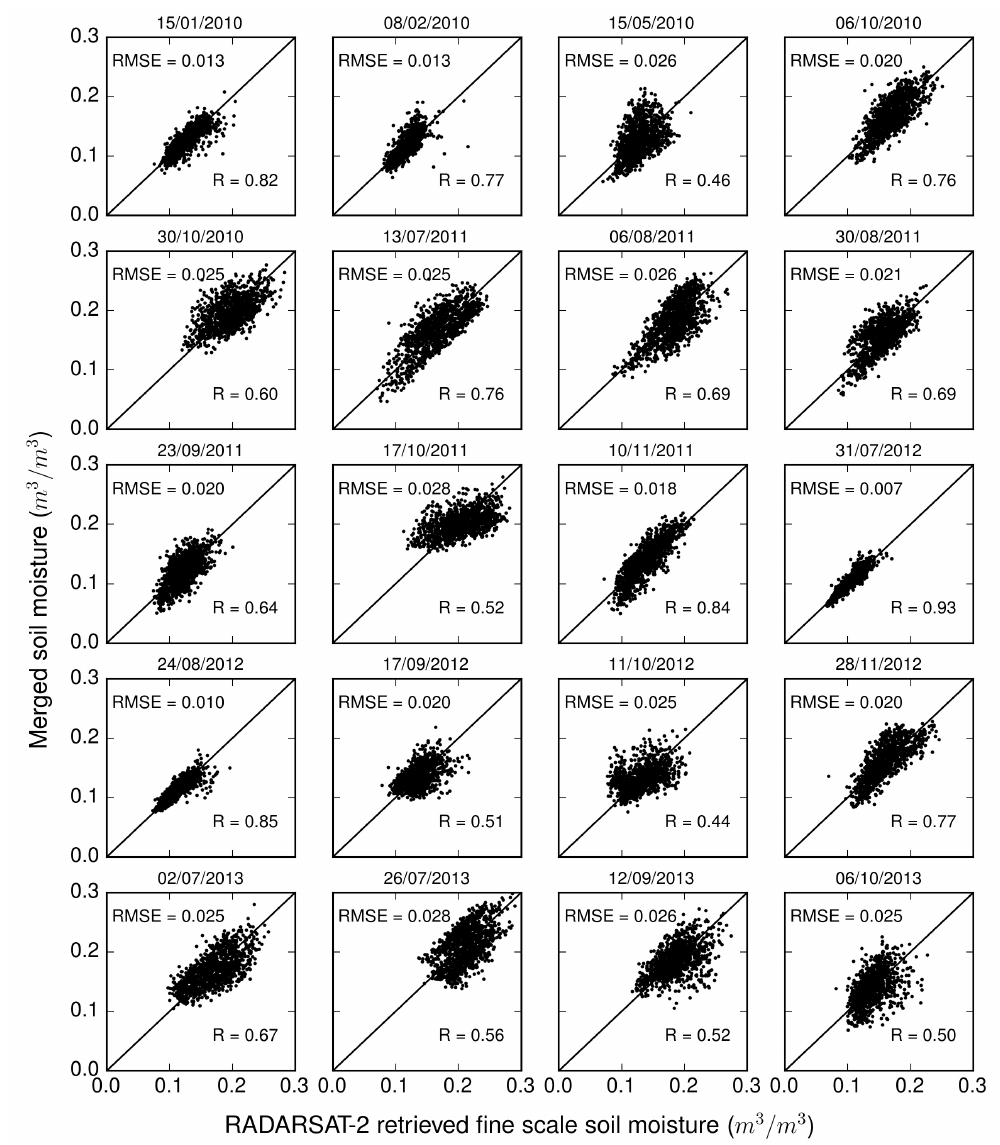
Figure 14. Comparison of the merged soil moisture with the RADARSAT-2 retrieved soil moisture at a spatial resolution of 500 m for the F-Linear